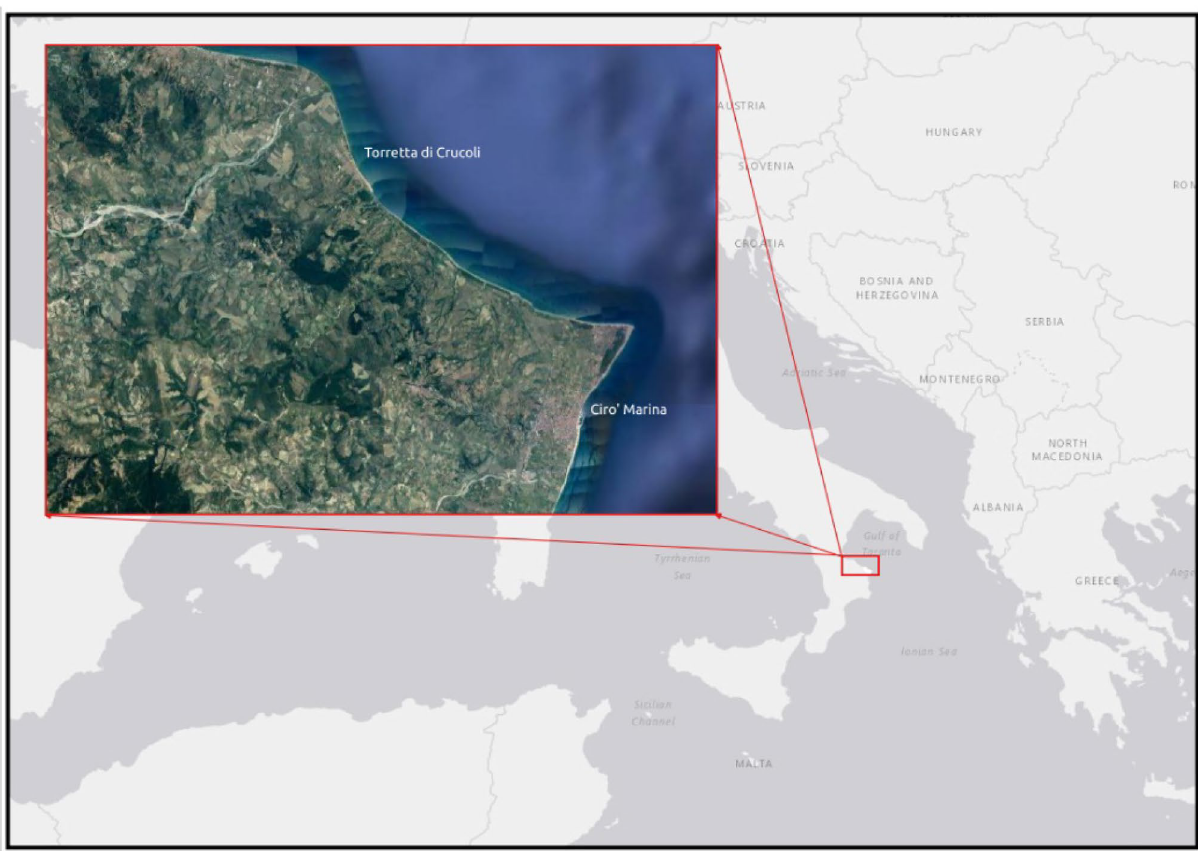
Figure 1. Case study area. Torretta di Crucoli – Cirò Marina, Calabria region, Italy. The map was created using QGIS 3.29 software (https:// qgis.